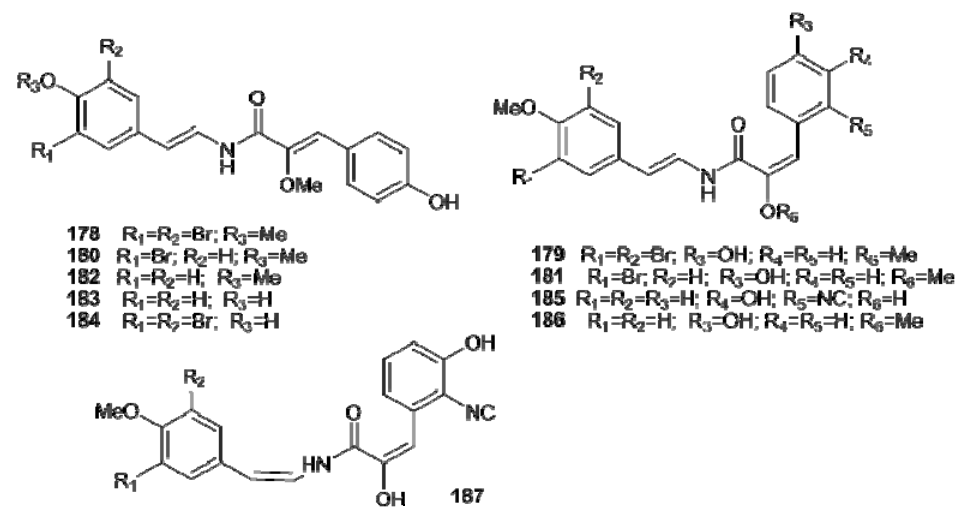
Figure 20. Structures of botryllamides A–J ( 178–187 ).